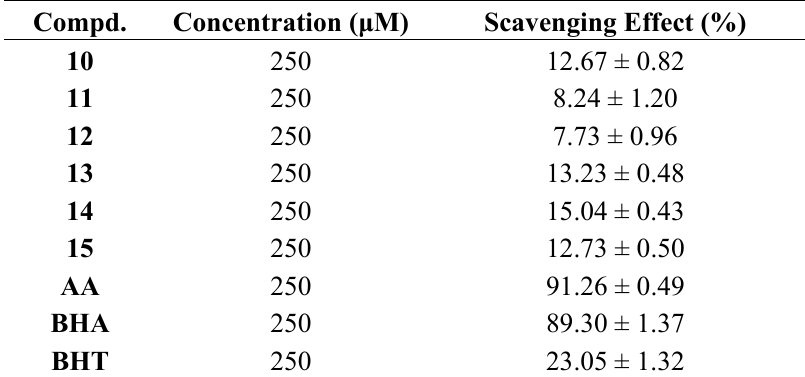
Table 2. Antioxidant activity of compounds 10 – 15 by DPPH method.